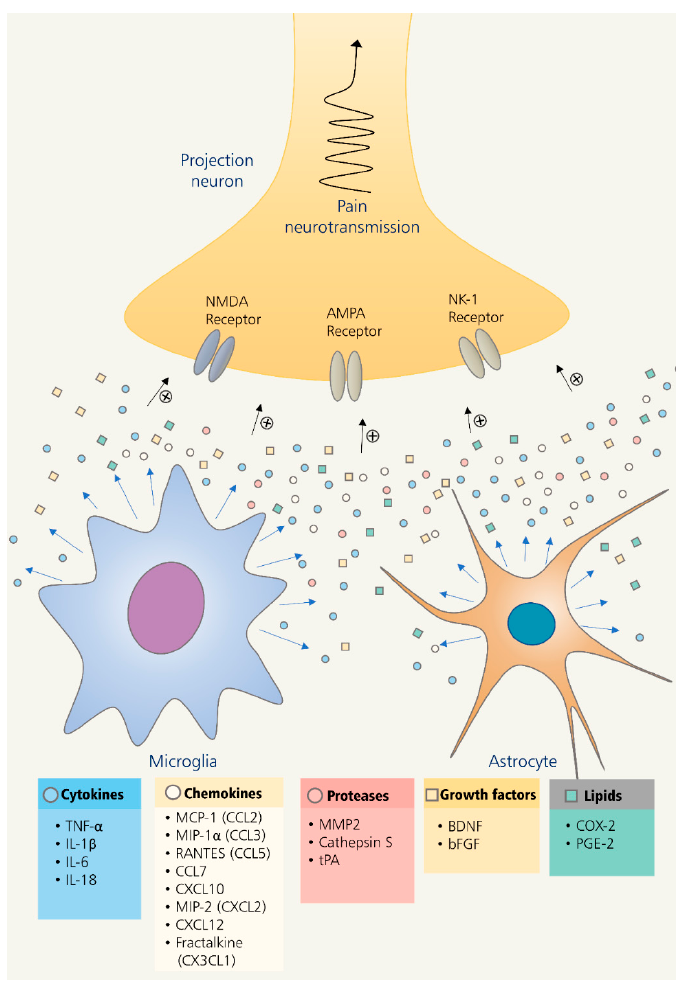
Figure 1. Pro-inflammatory mediators released by microglia and astrocytes activate projection neurons in the spinal cord. The mediators released by microglia and astrocytes include cytokines (TNF- α , IL-1 β , IL-6, IL-18), chemokines (MCP-1, MIP-1 α , RANTES, CCL7, CXCL10, MIP-2, CXCL12, fractalkine), proteases (MMP2, cathepsin S, tPA), growth factors (BDNF, bfGF), and lipids (COX-2, PGE2). Abbreviation: AMPA receptor, α -amino-3-hydroxy-5-methyl-4-isoxazole propionic acid receptor; BDNF, brain-derived neurotrophic factor; bfGF, basic fibroblast growth factor; CCL2, chemokine (C-C motif) ligand 2; CCL3, chemokine (C-C motif) ligand 3; CCL5, chemokine (C-C motif) ligand 5; CCL7, chemokine (C-C motif) ligand 7; COX-2; cyclooxygenase-2; CXCL2 chemokine (C-X-C motif) ligand 2; CXCL10, chemokine (C-X-C motif) ligand 10; CXCL12, chemokine (C-X-C motif) ligand 12; CX3CL1, chemokine (C-X3-C motif) ligand 1; IL-18, interleukin-18; IL-1 β , interleukin-1 β ; IL-6, interleukin-6; MCP-1, monocyte chemoattractant protein-1; MIP-1 α , macrophage inflammatory protein-1 α ; MIP-2, macrophage inflammatory protein-2; MMP2, matrix metalloproteinase-2; NK-1 receptor, neurokinin 1 receptor; NMDA receptor, N-methyl D-aspartate (NMDA) receptor; PGE2, prostaglandin E2; RANTES, regulated on activation, normal T cell expressed and secreted; TNF- α , Tumor necrosis factor- α ; tPA, tissue-type plasminogen